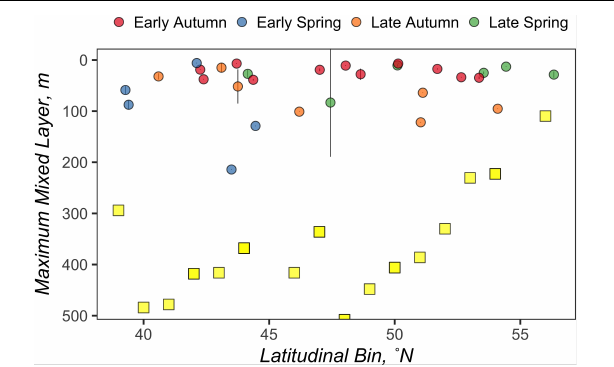
FIGURE 2 | The average mixed layer depth between all CTD casts at a station is represented by an individual circle, the color of which represents the season when that mixed layer depth was observed. Error bars represent standard deviations. Yellow squares represent the maximum mixed layer depths measured by the NAAMES ARGO floats for each latitudinal